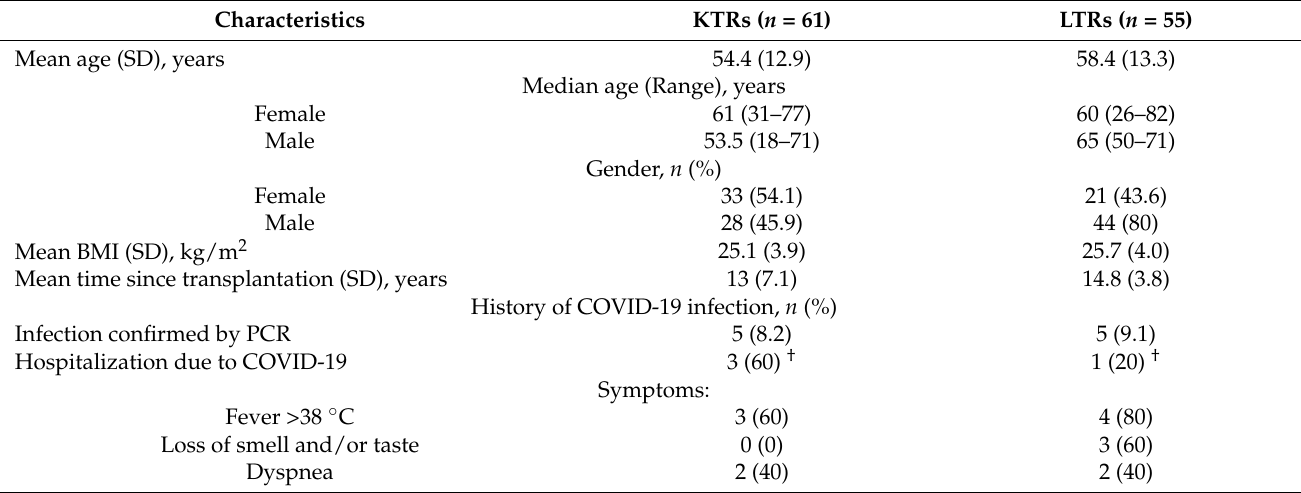
Table 1. Demographic and clinical characteristics of study participants